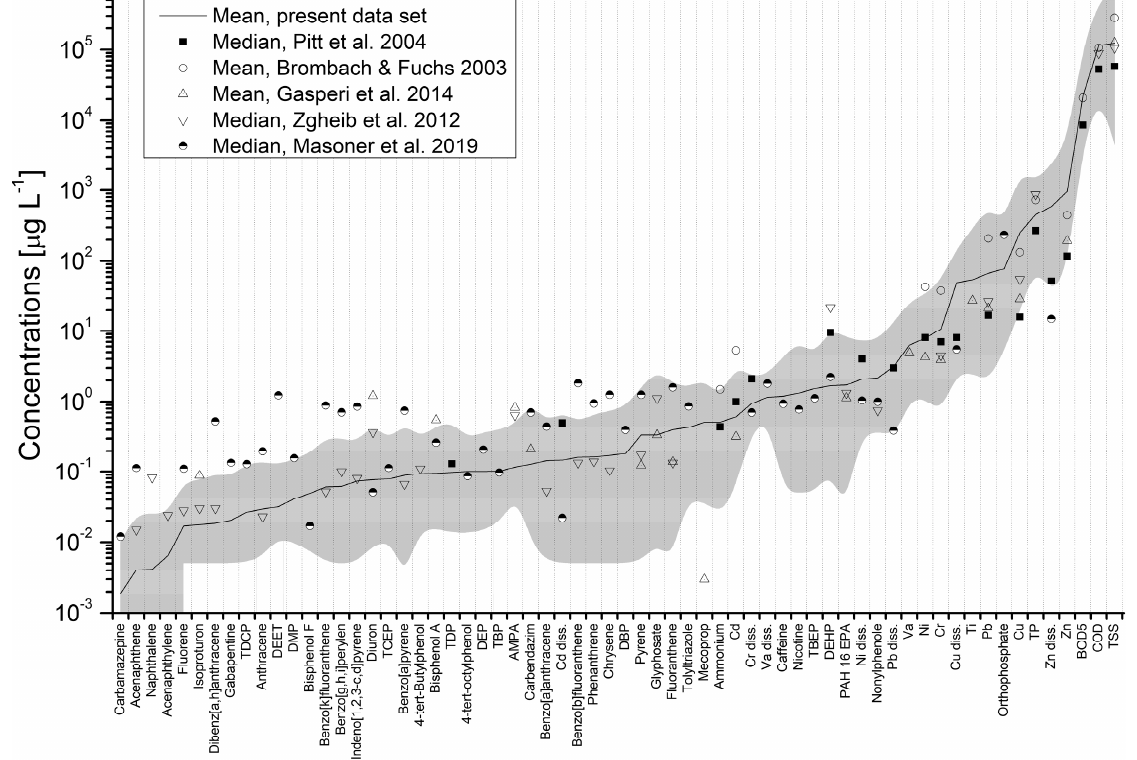
Figure 2. Comparison of means (black line) and 95% interval (grey area between 2.5% and 97.5% quantiles) with literature values on stormwater runoff in separated sewer systems.